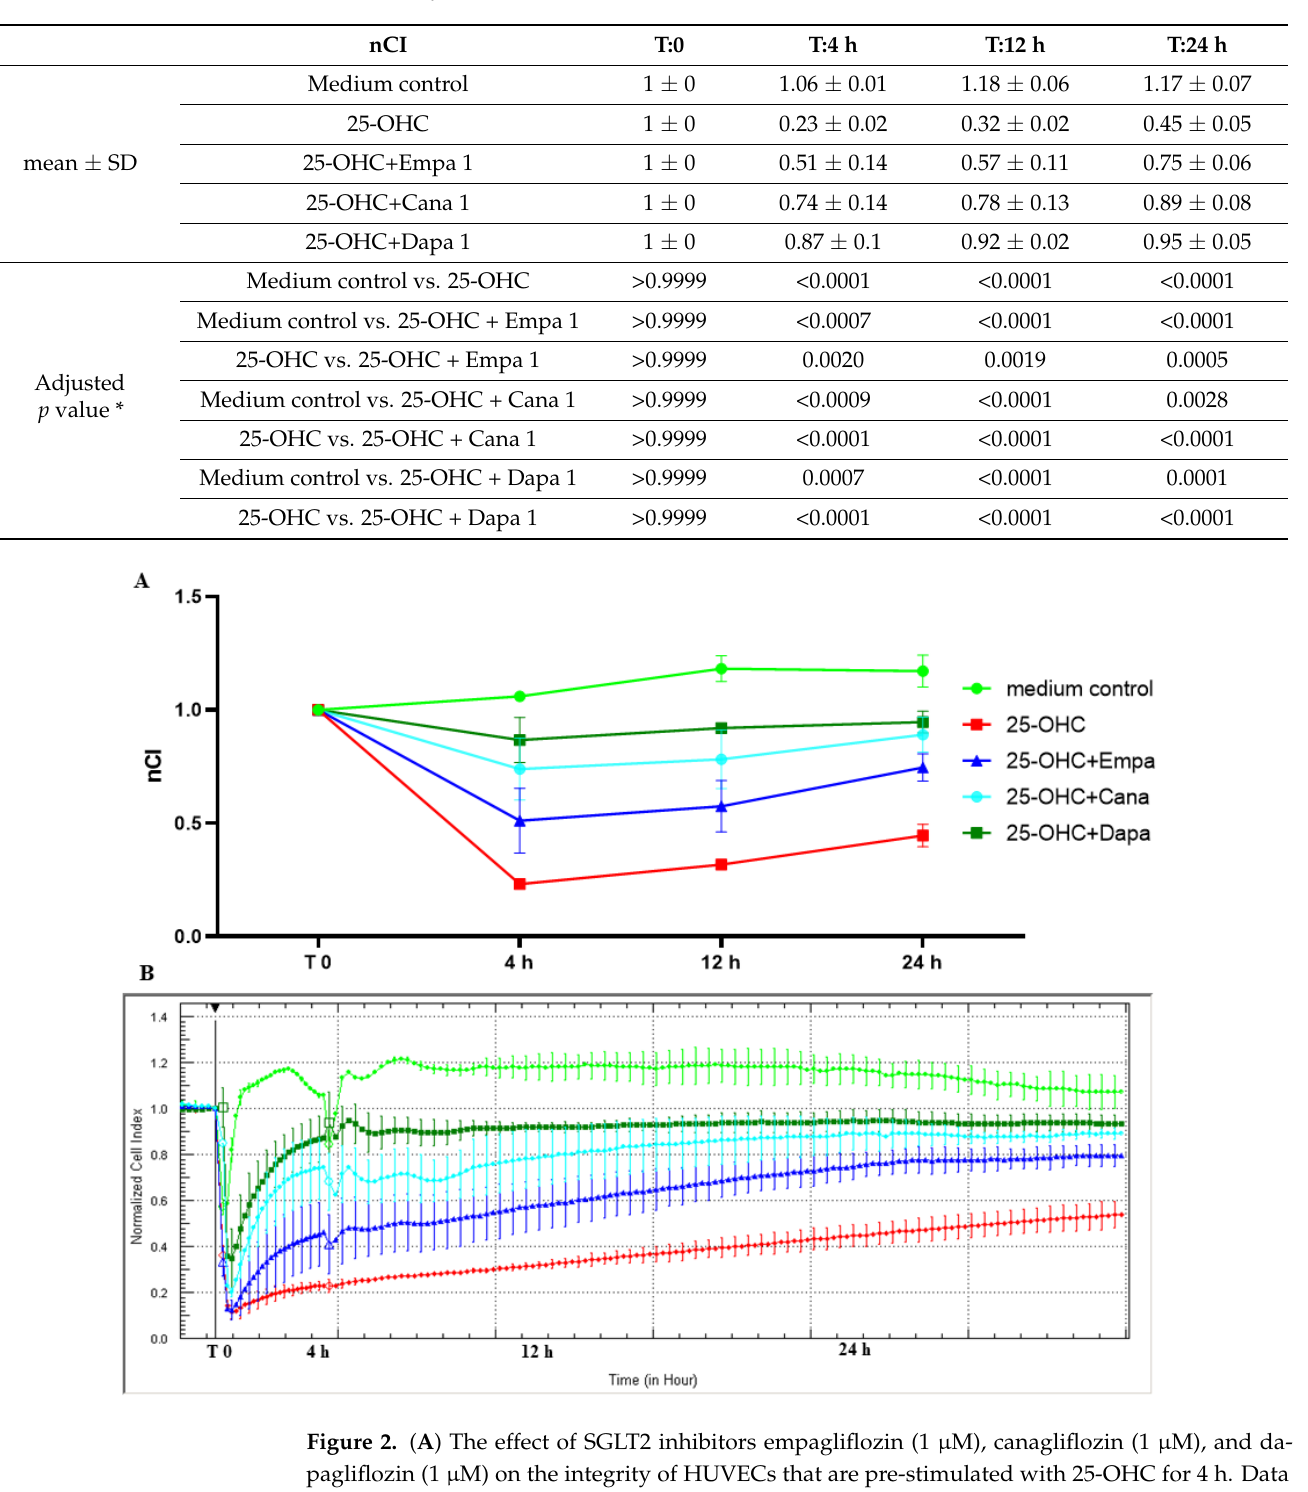
Table 2. Summary of the normalized cell index (nCl) of HUVECs that are pre-stimulated with 25-OHC for 4 h and then with SGLT2 inhibitors empagliflozin (1 µM), canagliflozin (1 µM), or dapagliflozin (1 µM), in three time points T0, 4 h, 12 h, and 24 h. * Adjusted p value of Tukey multiple comparisons tests in 2-way ANOVA.